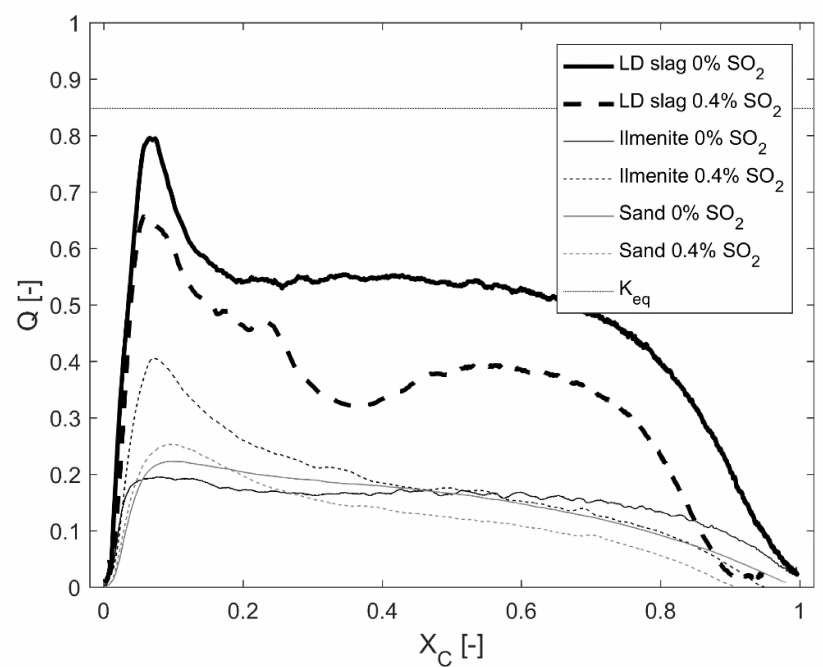
Figure 11. The reaction quotient Q for LD slag, ilmenite, and sand with and without the presence of SO 2 in the fluidization gas plotted against the conversion of the ingoing carbon, X c . Experiments were performed at 870 ◦ C using 0.2 g fuel. The dotted horizontal line in the figure is the equilibrium constant K eq for the WGS reaction at 870 ◦